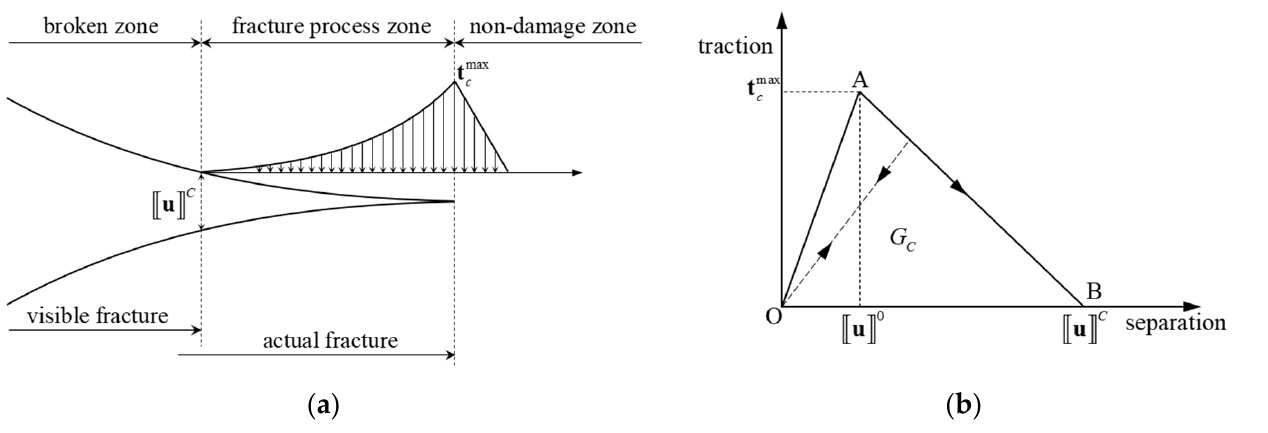
Figure 2. Diagram of the cohesive zone model. ( a ) Cohesive zone, and ( b ) bilinear cohesive law.